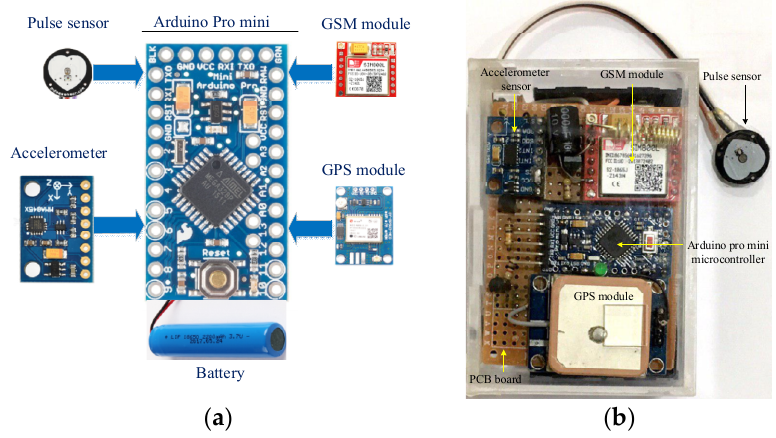
Figure 5. Proposed AWHMS device: ( a ) schematic diagram and ( b ) hardware.